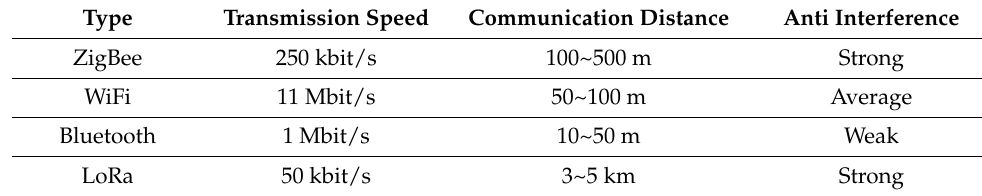
Figure 2. System overall schematic diagram. Table 1. Common wireless communication